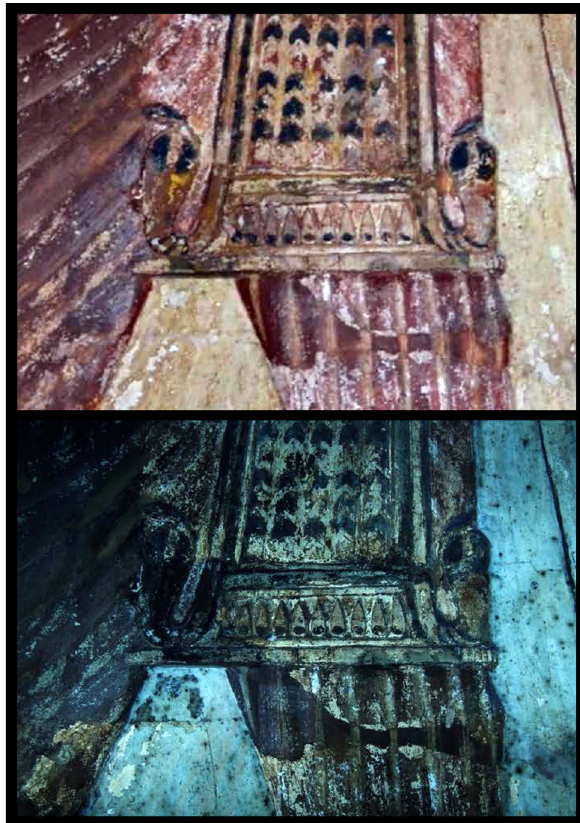
Figure 12. Visible and Uvf images of the integrated area on the skirt of Sethi I. the repainted area is clearly